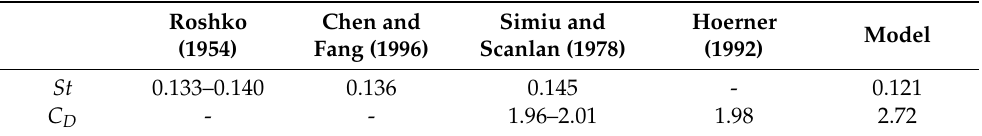
Table 4. Values of the Strouhal number and drag coefficient of a flat plate normal to the flow given by [9,20,27,31] in comparison with the results obtained from the